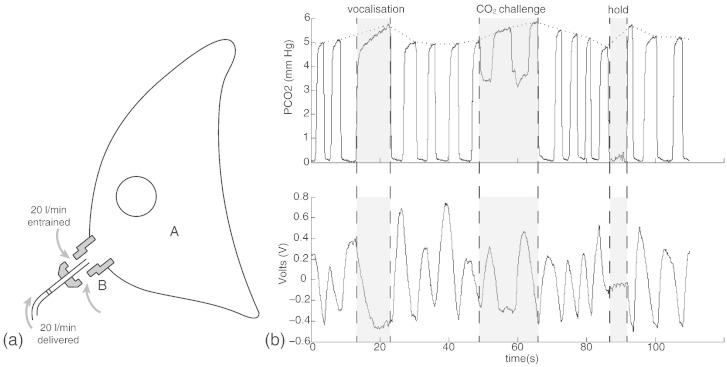
a) Schematic diagram of the venturi mask used in the breathing system. A: Loose plastic venturi mask B: Venturi entrainment device (1:1). b) A section of a respiratory trace from one subject demonstrating the tidal CO2 trace (top) and the tidal volume trace from the bellows (bottom). The end-tidal CO2 (PETCO2) trace was formed by interpolating between the end expiration peaks (dotted line, top trace). The breath hold duration was calculated from the time between the end of expiration CO2 trace and the beginning of the subsequent expiration trace, to minimise inclusion of head movement. The vocalisation duration was calculated from the duration between the beginning and end of a vocalisation expiration trace.